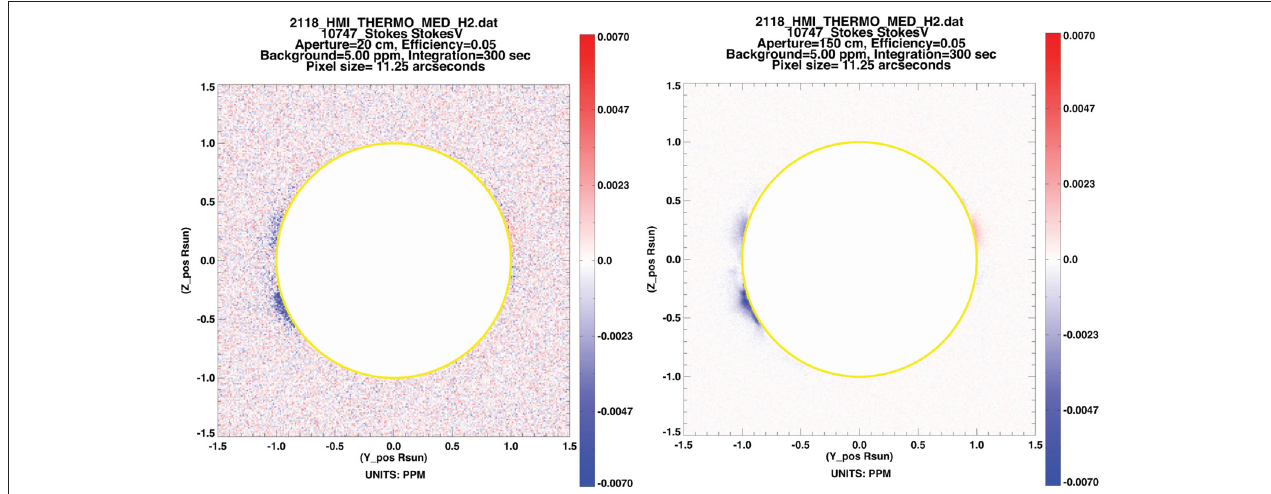
FIGURE 15 | Stokes V/I for MAS model as in Figure 6C, with the addition of photon noise expected for 5 min integration for a 20cm (e.g., MLSO/CoMP) vs. a 150cm (e.g., proposed COSMO) telescope. Note systematic errors are not included. Plots obtained by (left) for_drive,readmap='psimas_10747_ 01042012',line='V',/donoise and (right) same, with addition of aperture=150